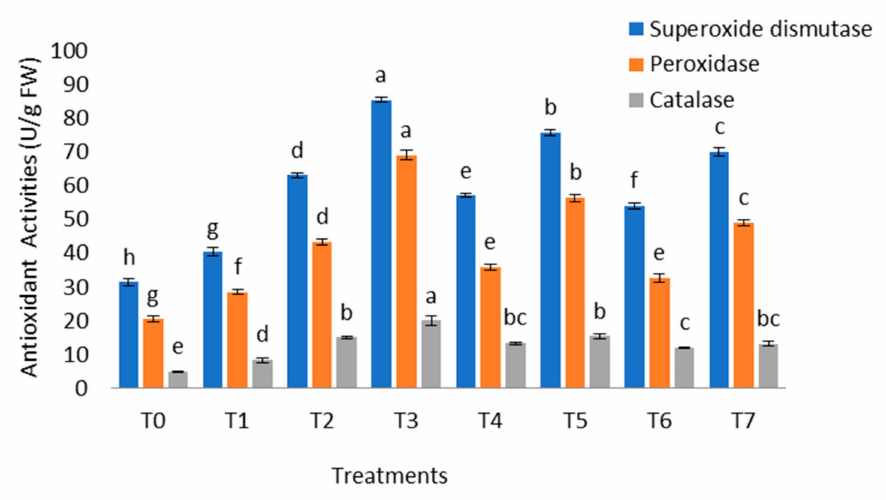
Figure 4. Effect of bacillus inoculation on antioxidant activities of B. nigra L. facing chromium stress. Where T0 = Control, T1 = B. cereus , T2 = Cr-20 mg/kg, T3 = Cr-20 mg/kg + B. cereus , T4 = Cr-30 mg/kg, T5 = Cr-30 mg/kg + B. cereus , T6 = Cr-40 mg/kg, T7 = Cr-40 mg/kg + B. cereus . Mean and standard deviations are shown in the figure. Different letters indicate significant differences between means of treatments at p < 0.05 according to the LSD